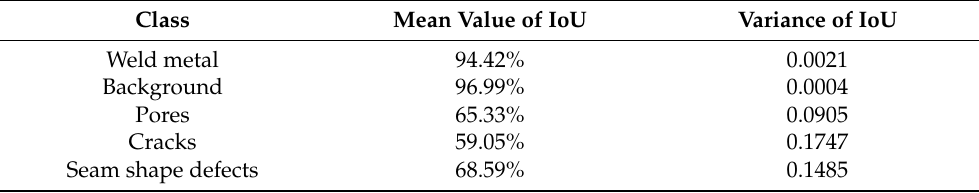
Table 8. Comparison of five classes with image resolution 2048 × 1024 based on 57 micrographs.